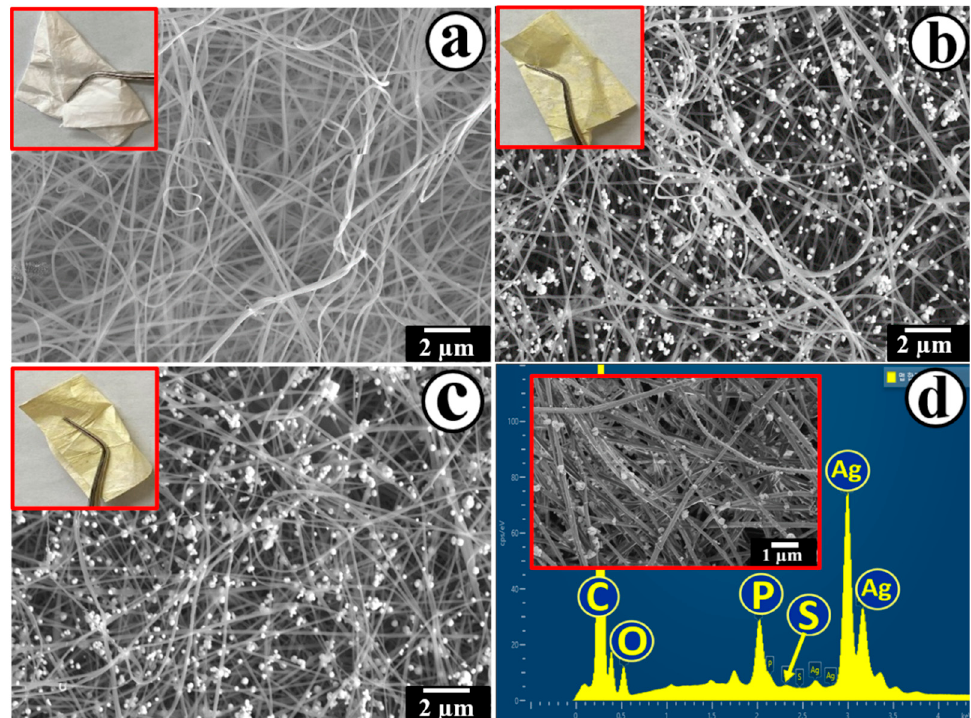
Figure 2. FESEM images; ( a ) Na 2 HPO 4 /PAN nanofibers, ( b ) AP/PAN, ( c ) SAP/PAN. Panel ( d ) represents the corresponding EDS of ( c ). Insets in Figure ( a , b , and c ) are digital photograph of corresponding nanofibers and inset in Figure ( d ) is FESEM image of used SAP/PAN.